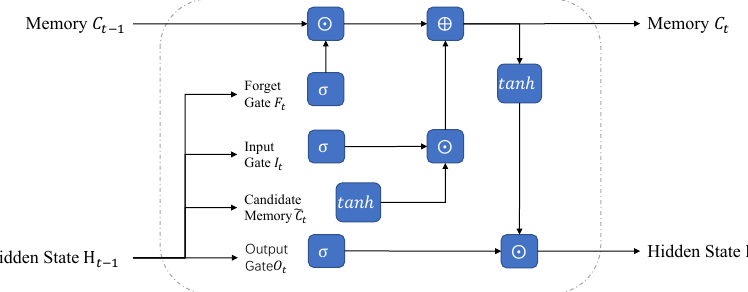
Figure 2. The architecture of